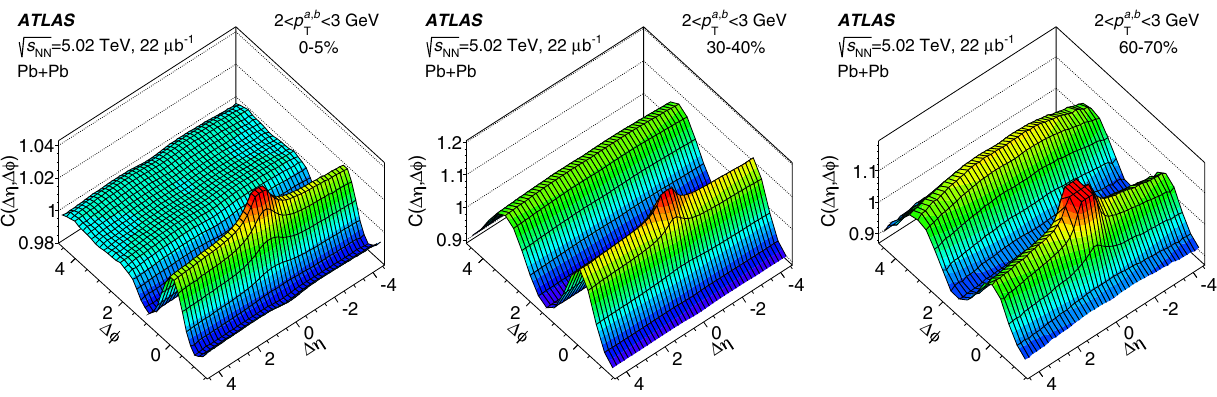
Fig. 2 Two-particle correlation functions C ((cid:11)η,(cid:11)φ) in 5.02 TeV ity classes, respectively. The distributions are truncated to suppress the < 3 GeV. The left, middle and peak at (cid:11)η = (cid:11)φ = 0 to show the long-range correlations in greater Pb+Pb collisions for 2 < p a , b T right panels correspond to the 0–5%, 30–40% and 60–70% central-